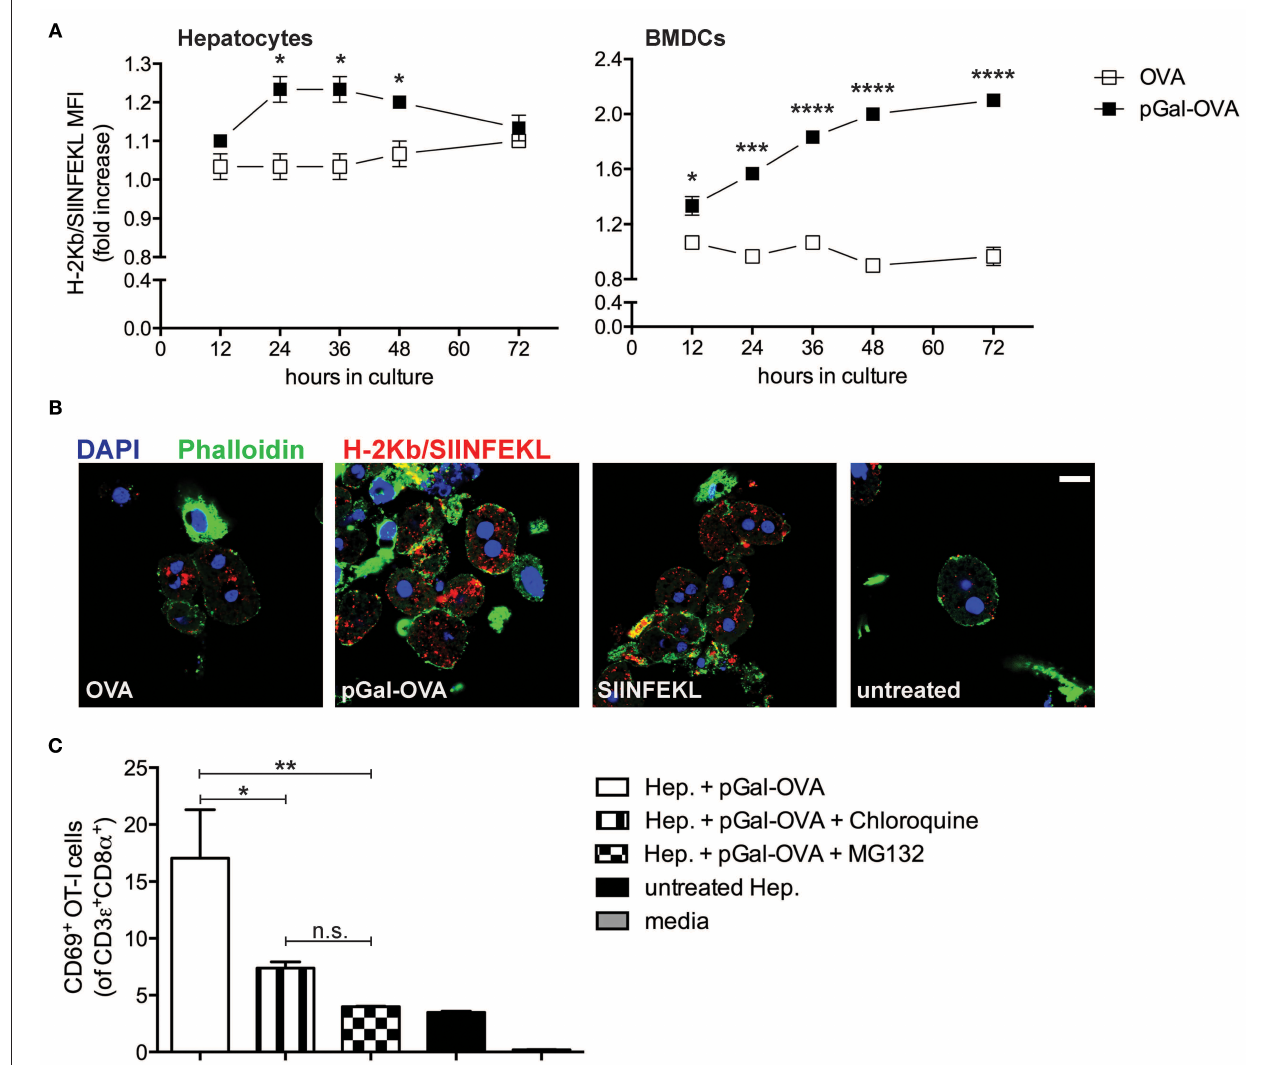
FIGURE 3 | Polymer containing side-chain N-acetylgalactosamine (pGal) conjugate with OVA improves cross-presentation of extracellular OVA. (A) Culture of primary hepatocytes (left) or BMDCs (right) from C57BL/6 mice with pGal-OVA (black squares) increases the amount of H-2Kb-bound SIINFEKL detected by flow cytometric analysis as compared to culture with unmodified OVA (white squares). (B) H-2Kb/SIINFEKL staining of C57BL/6 primary hepatocytes after 24h culture in the presence of either 5 µ M OVA, 5 µ M pGal-OVA, 1nM OVA 257 − 264 , i.e., SIINFEKL, or left untreated confirms efficient cross-presentation of pGal-OVA. Scale bar = 10 µ m. (C) Treatment of primary hepatocytes with either chloroquine or MG132 significantly reduces the cross-presentation of pGal-OVA by primary hepatocytes to H-2Kb/SIINFEKL-specific OT-I cells, as indicated by staining for the early T cell antigen-sensing and activation marker CD69 on the surface of OT-I cells. * P < 0.05, ** P < 0.01, *** P < 0.001, **** P < 0.0001 and n.s., not significant (one-way ANOVA and Bonferroni post-hoc test correction). Data are representative of 3 independent experiments [ n = 3; mean and s.e.m. in (A,C)